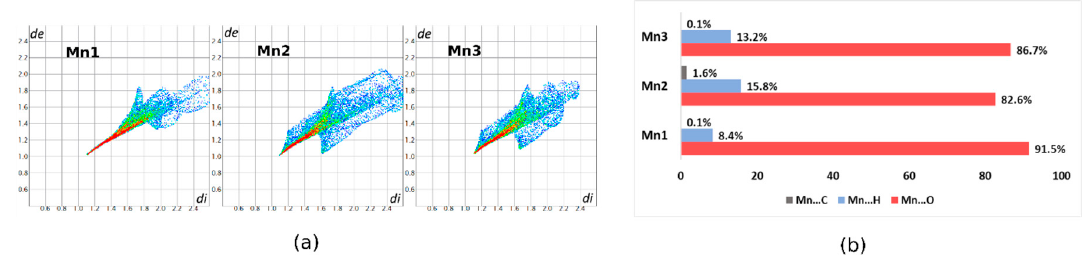
Figure 3. ( a ) Fingerprint plot for the Hirshfeld Surface of the metal centers Mn1, Mn2 and Mn3 of 1 ; ( b ) The percentage contribution of contacts of the Mn 2+ in the coordination polymer of 1 .